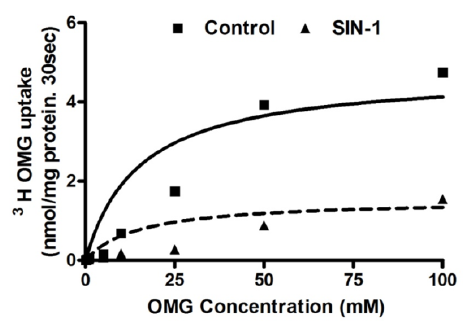
Figure 6. Kinetic parameters for SGLT1 activity in SIN-1 treated IEC-18 cells. Na-dependent glucose uptake is shown as a function of varying concentrations of extravesicular glucose. Isosmolarity was maintained by adjusting the concentration of mannitol. Uptake for all concentrations was determined at 30 s. As the concentration of extravesicular glucose was increased, uptake of glucose was stimulated and subsequently became saturated in IEC-18 cells in all conditions. The maximal rate of uptake of glucose (V max ) was significantly reduced by SIN-1 treatment but the affinity (1/K m ) for glucose uptake was unaffected in the SIN-1 treated IEC-18 cells. (n = 3, * p < 0.05).